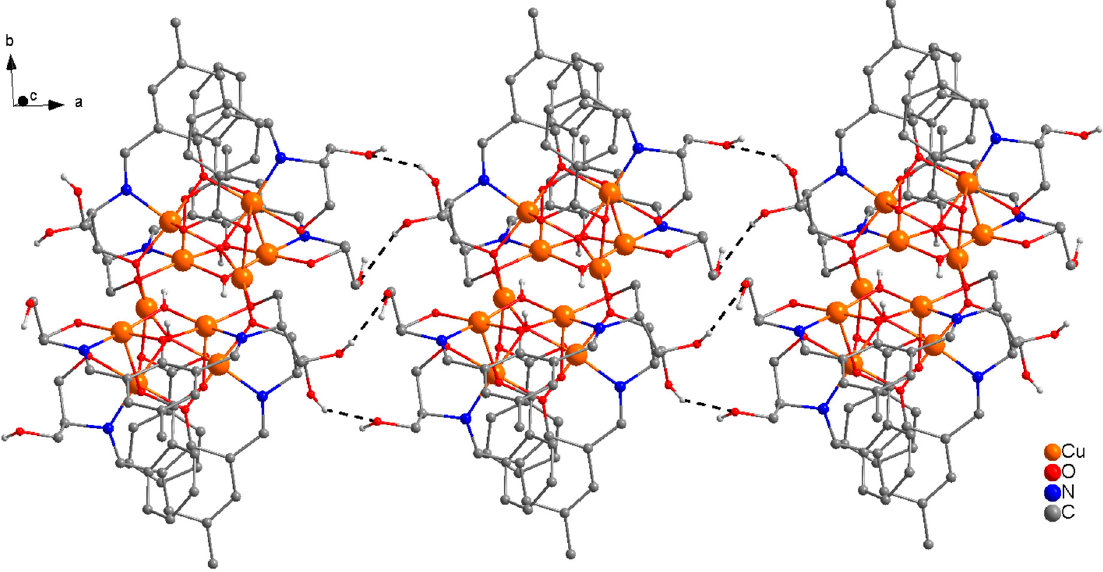
Figure 11. Perspective view of a portion of 1D-single chain along a -axis in the structure of 6 .